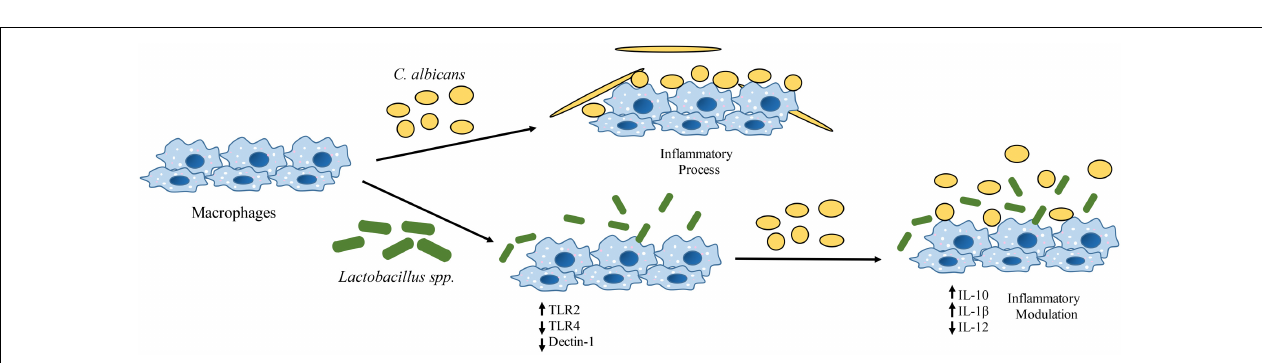
FIGURE 6 | Relative transcription of TLR4 (A) and TLR2 (B) in macrophages challenged with LPS, C. albicans , or pretreated with LPS before C. albicans challenge. Transcription of TLR4 (C) and TLR2 (D) in macrophages pretreated with probiotics alone or both LPS and probiotics before C. albicans or LPS challenge. Gene expression was normalized to GAPDH transcripts levels in the same cDNA set. Groups with no probiotic bacteria pretreatment were set at 1. Data are presented as mean ± SD. ∗ p < 0.05; ∗∗ p < 0.01.